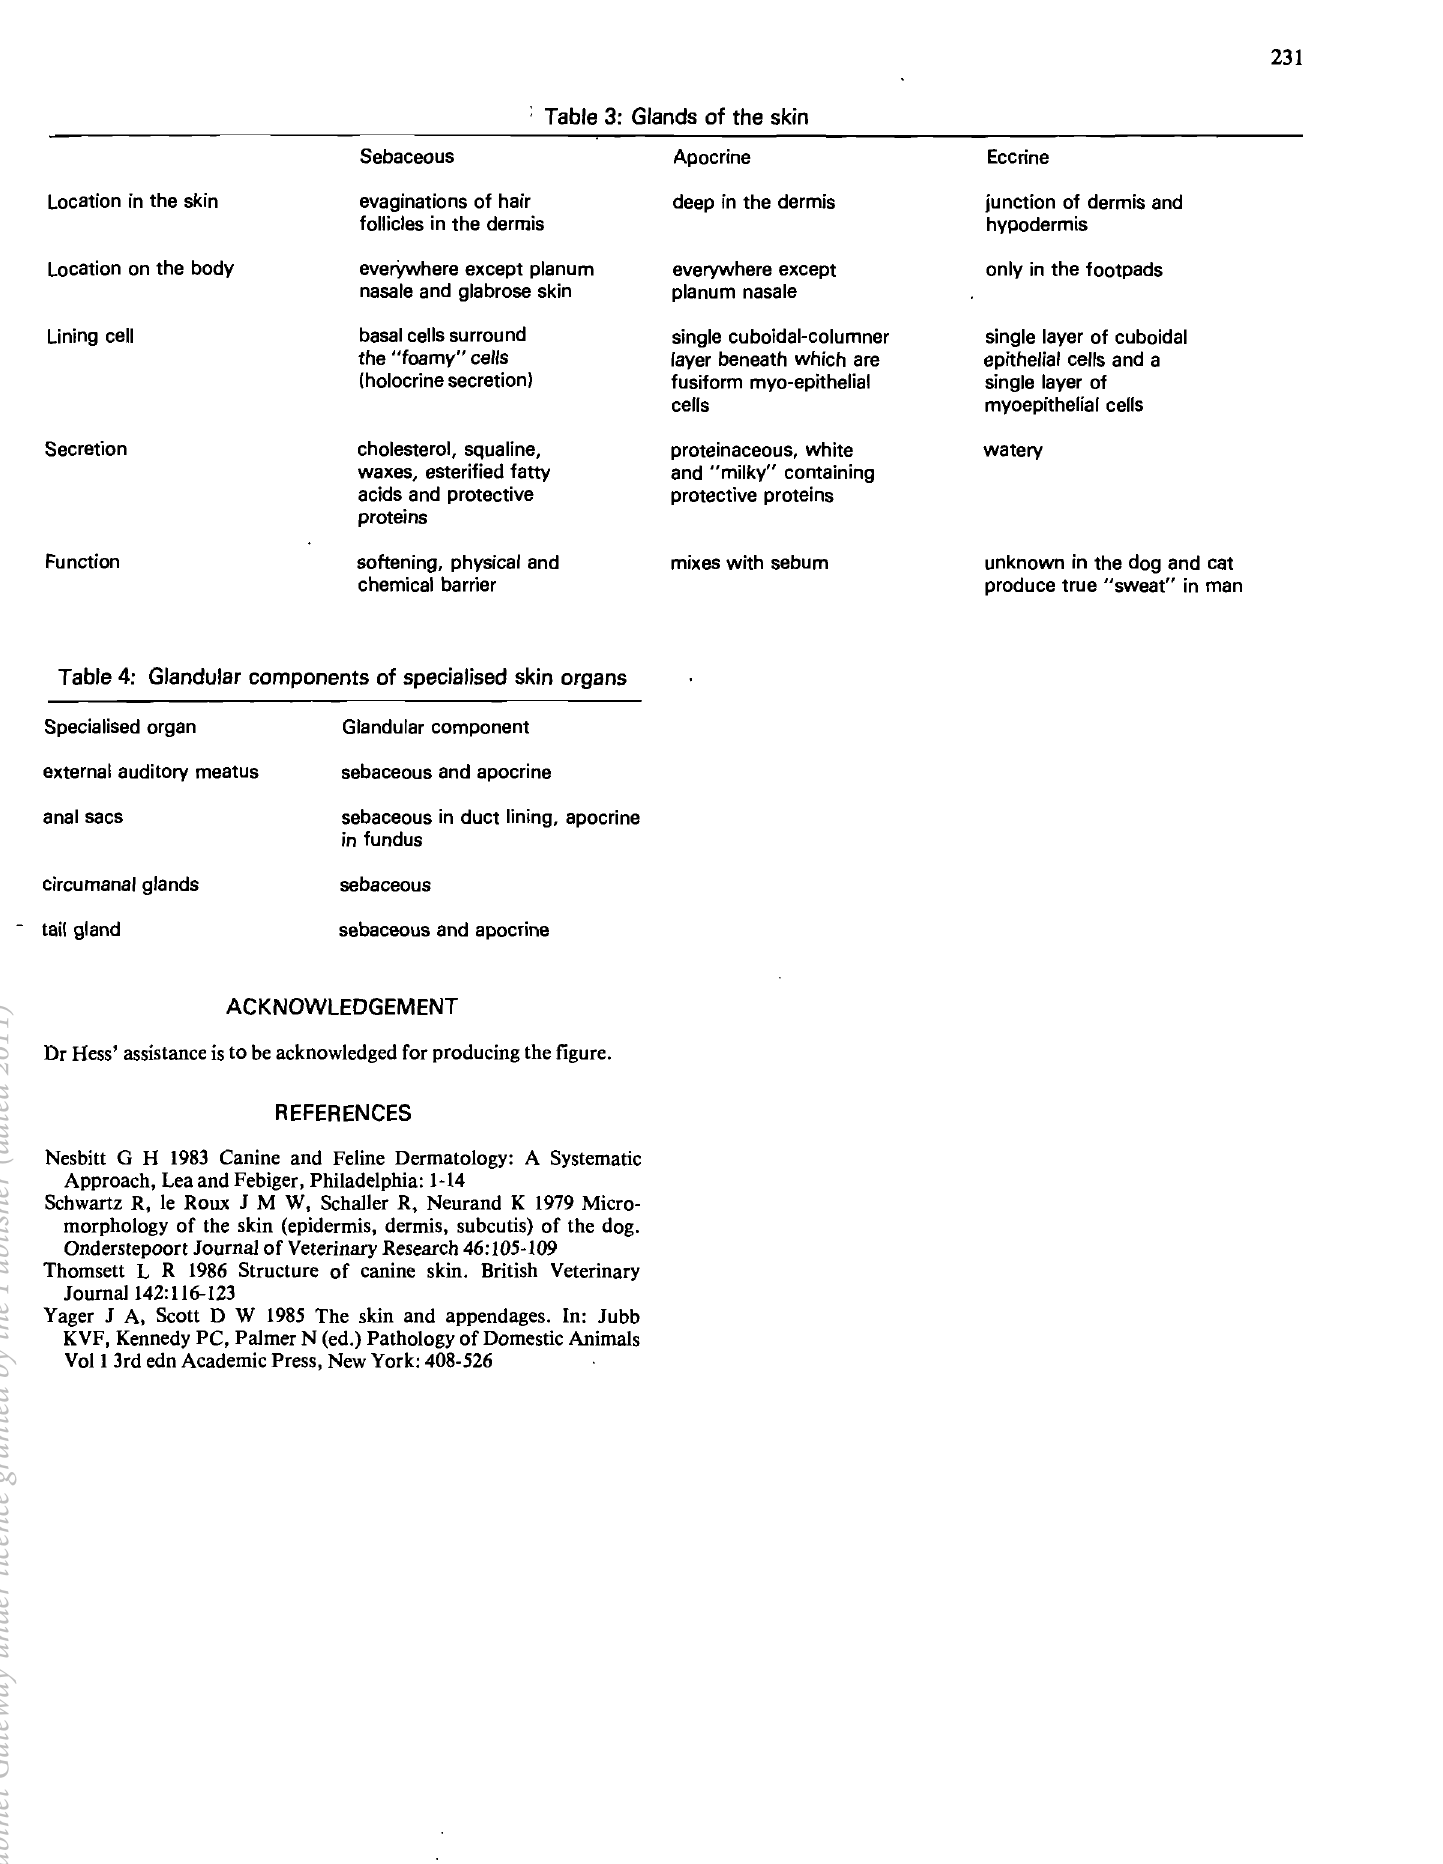
Table 3: Glands of the skin